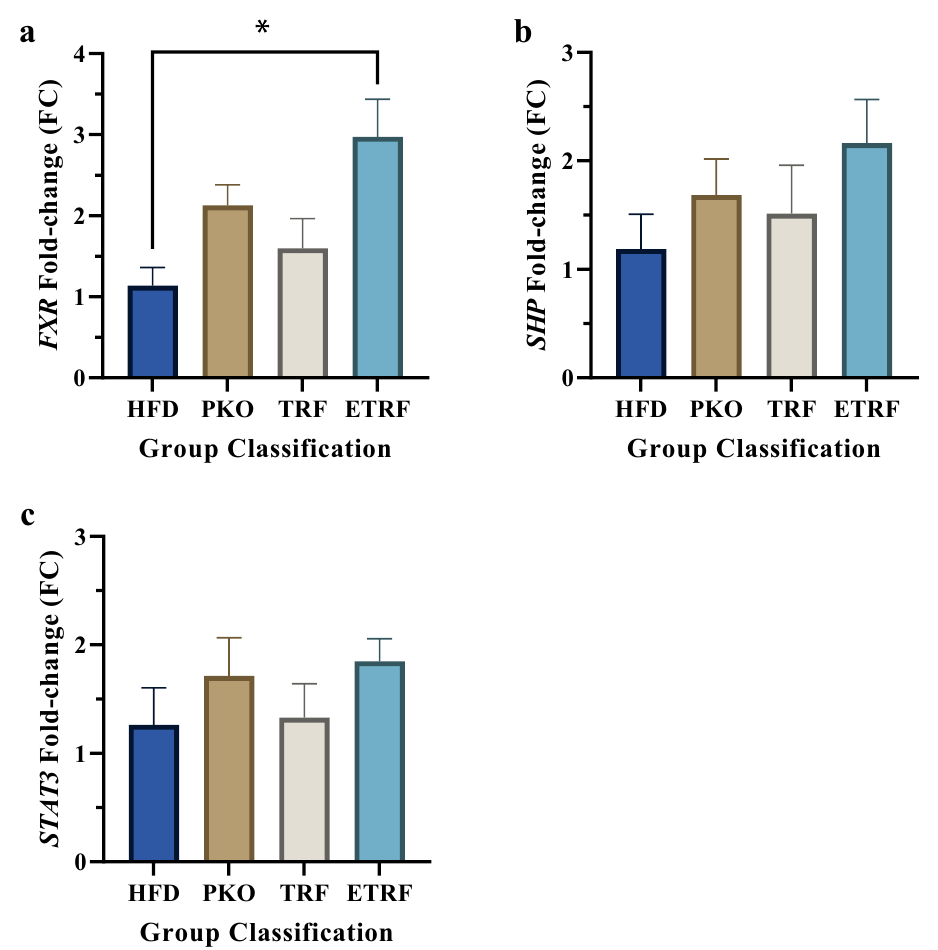
Figure 5. The effect of PKO, TRF and ETRF on liver fxr ( a ), shp ( b ) and stat3 ( c ) expressions based on fold- change (FC). The FC of liver fxr was found significant in ETRF compared to HFD but not with shp and stat3 . The expression of fxr and its target genes, shp and stat3 were found to be not significant in PKO and TRF. (n = 7) (* p <